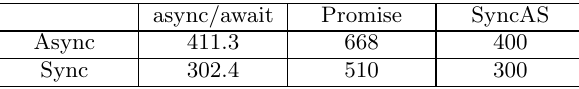
Table 2: Comparison by Performance in milliseconds async/await Promise